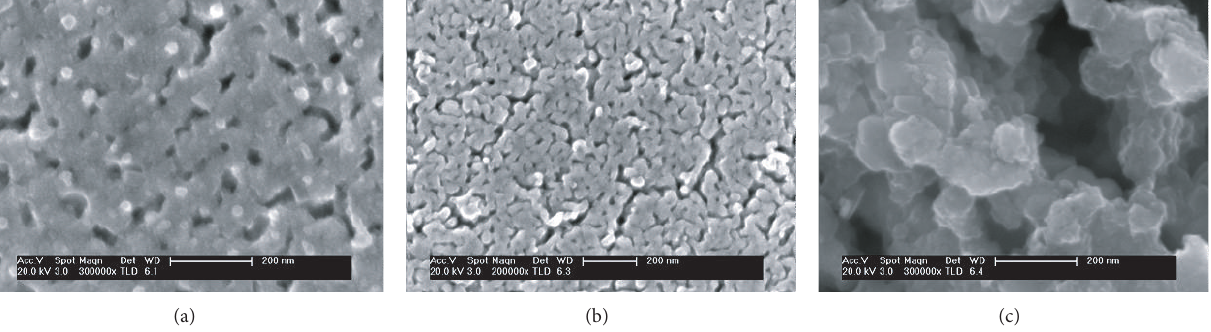
Figure 2: SEM images of NPC 1 number (a), NPC 2 number (b), and NPC 3 number (c).